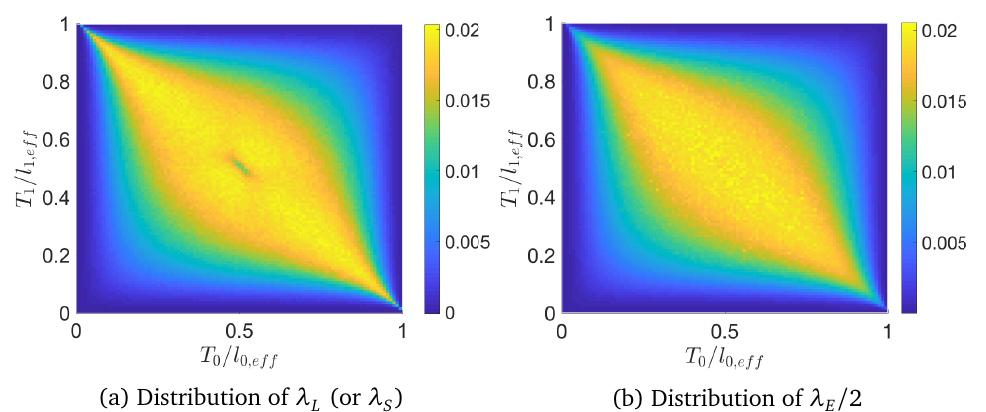
Figure 4: Distribution of Lyapunov exponents λ characterize the entanglement entropy growth, and λ ize the total energy growth (see (13)), as a function of T choose two random driving Hamiltonians H θ ities 1 / 2 and 1 / 2 respectively. We perform ensemble average over N = 2 × 10 4 ) in the calculation of λ ( N sample / l = T / l = 1 / 2. See also the schematic plot of phase diagram located at T 0 0,eff 1 1,eff